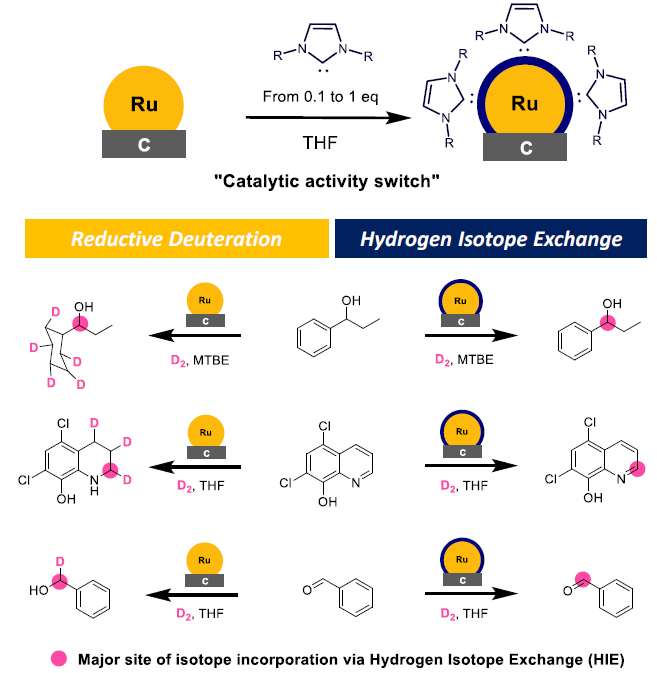
Figure 23. Top: Synthesis of Ru on carbon modified with NHCs (NHC@Ru/C). Bottom: Catalytic Figure 23. ( Top ): Synthesis of Ru on carbon modified with NHCs (NHC@Ru / C). ( Bottom ): Catalytic activity switch due to the functionalization of Ru/C with NHCs. Reproduced from reference 103. activity switch due to the functionalization of Ru / C with NHCs. Reproduced from reference